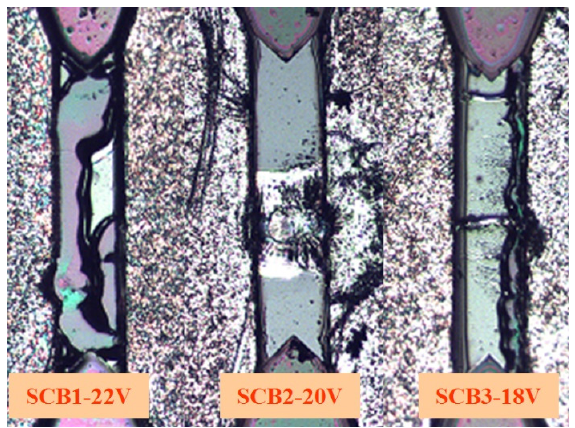
Figure 18. The initiation electric discharge characteristic curves with a different excitation voltage.